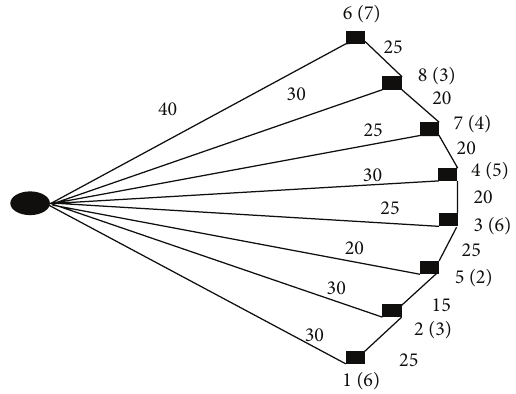
Figure 3: The distribution of customers.